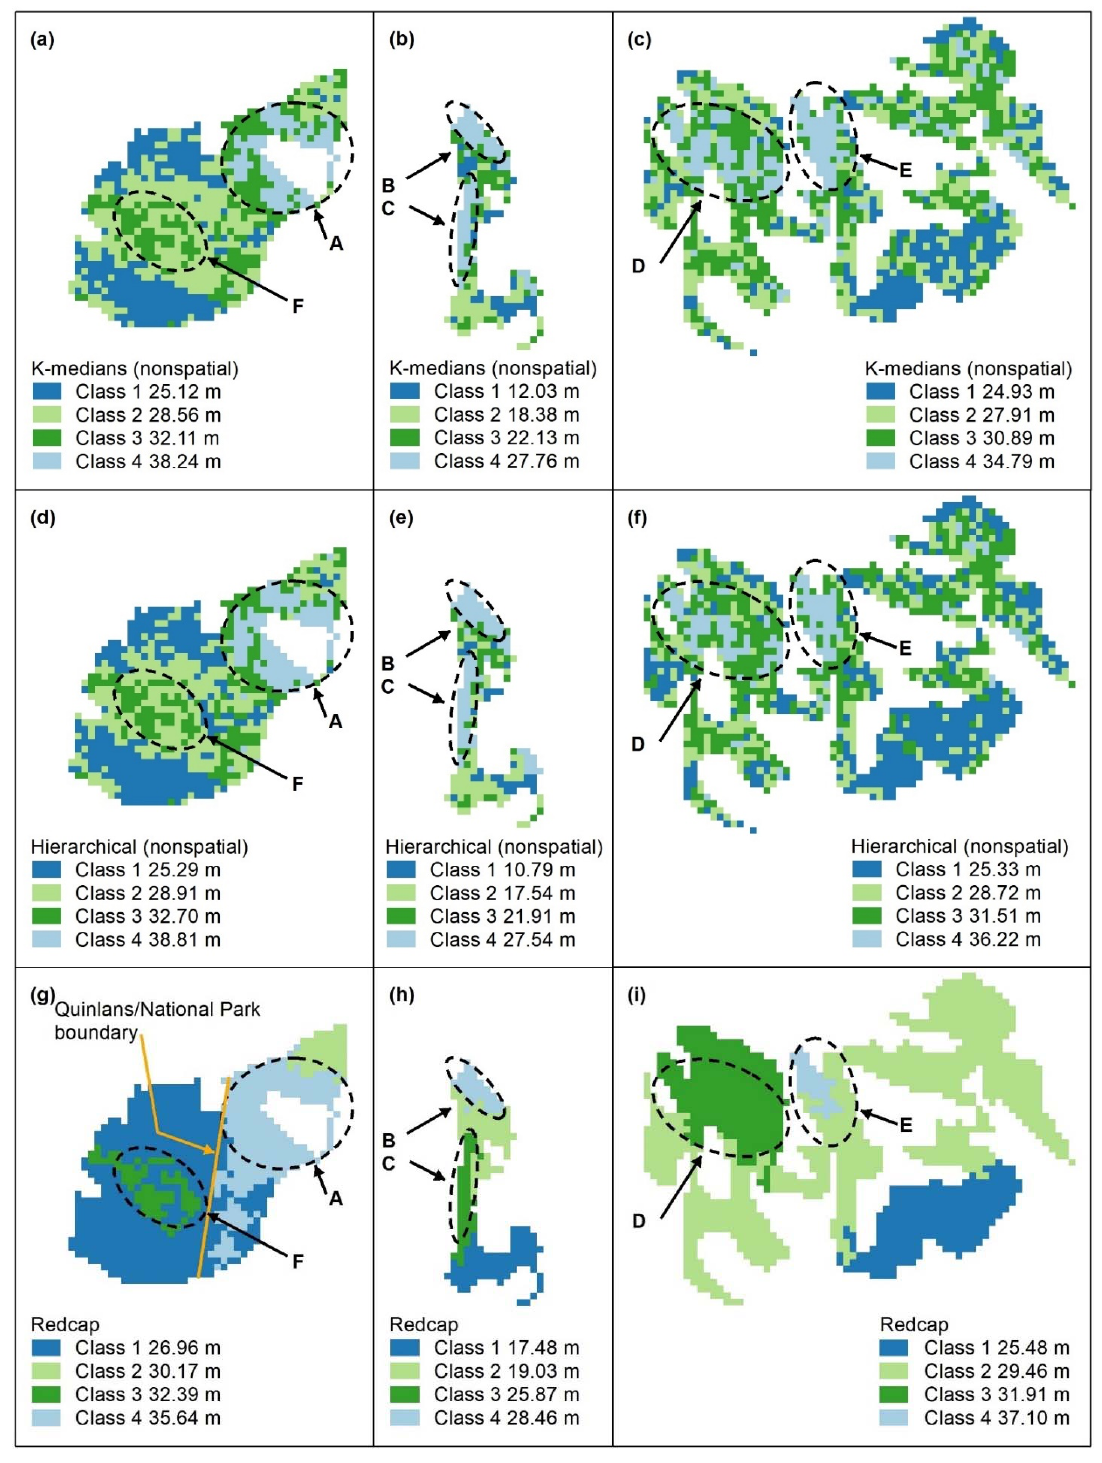
Figure 11. Nonspatial K ‐ medians ( a – c ), nonspatial hierarchical ( d – f ) and Redcap [64] spatial hierarchical ( g – i ) cluster maps for individual polygons (refer Figure 9) with 4 height classes. Letters A–F indicate areas of higher canopy as shown in Figure 9. All six features are identified, but features A, D, and F are not contiguous. In comparison, the spatially constrained algorithm Redcap ( g – i ) identifies all the features as contiguous but assigns C, D, and F to a lower height class. Compared to Figure 9, Redcap overestimates D and underestimates E; A is also larger, because it also captures height differences reflecting the land use history of Quinlans compared to Mapleton National Park. Redcap also accurately captures the extent of an ecotone identified during fieldwork (F); this ecotone has a higher proportion of a preferred koala food tree than the surrounding area (dark blue), and which is absent from the national